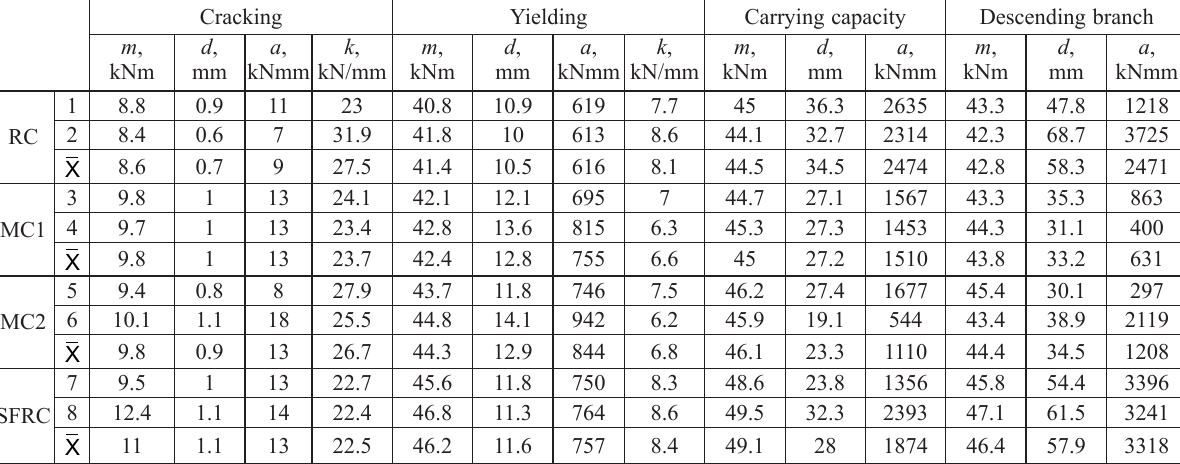
Table 2. Results obtained from flexural testing Cracking Yielding Carrying capacity Descending branch